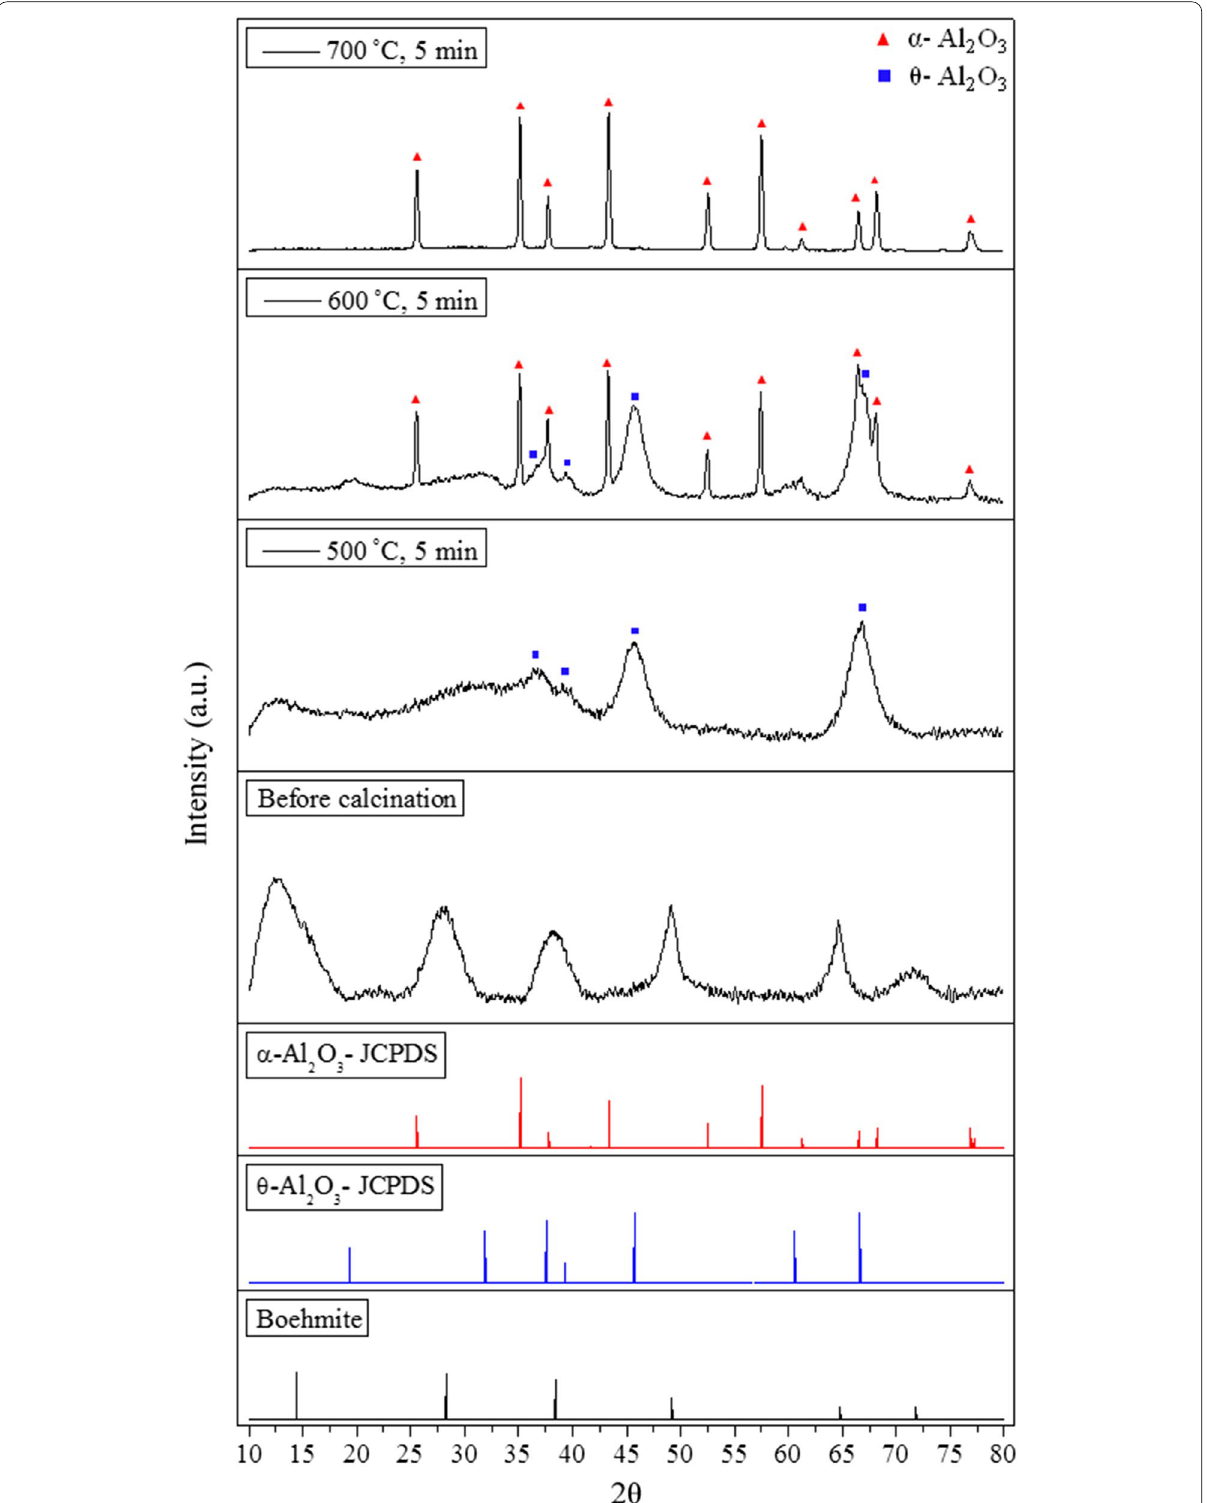
Fig. 12 Crystal phase of the aluminum hydroxide product changes with the calcination temperature (plasma